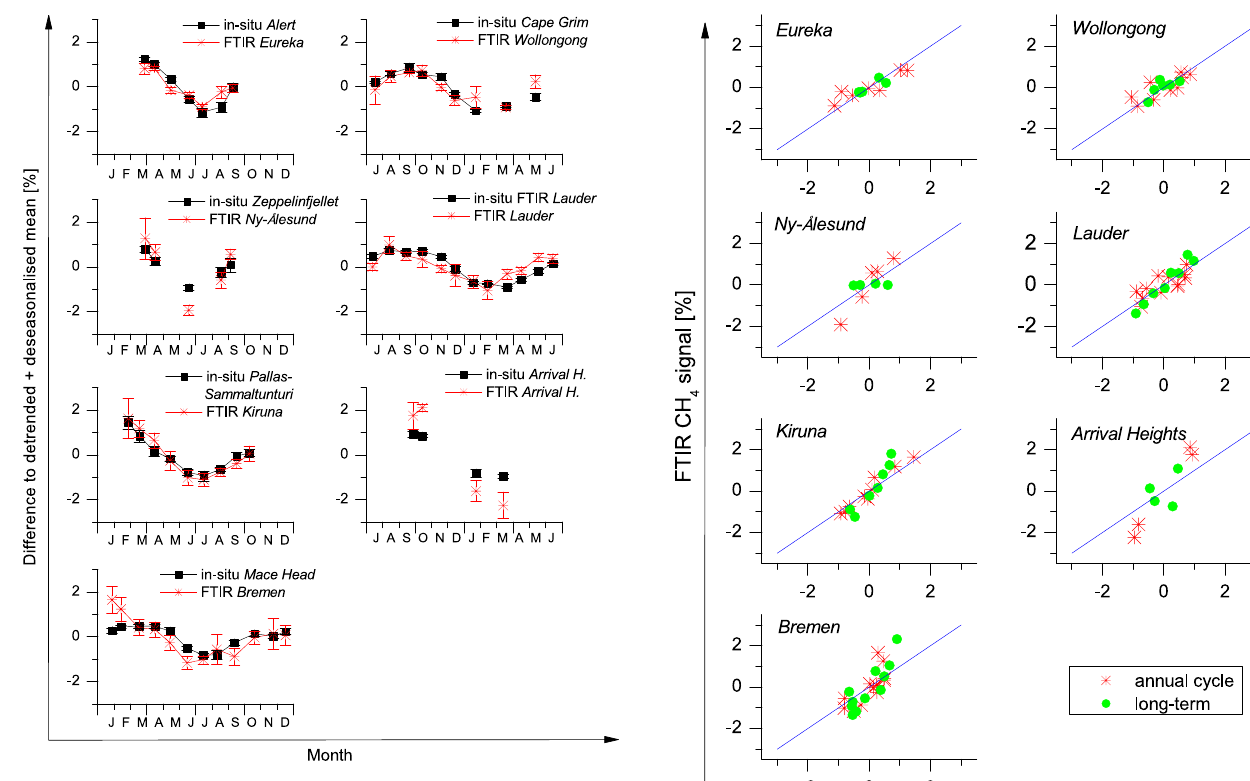
Figure 12. As Fig. 9 but for the rest of the stations. The stations names are shown in each graph.